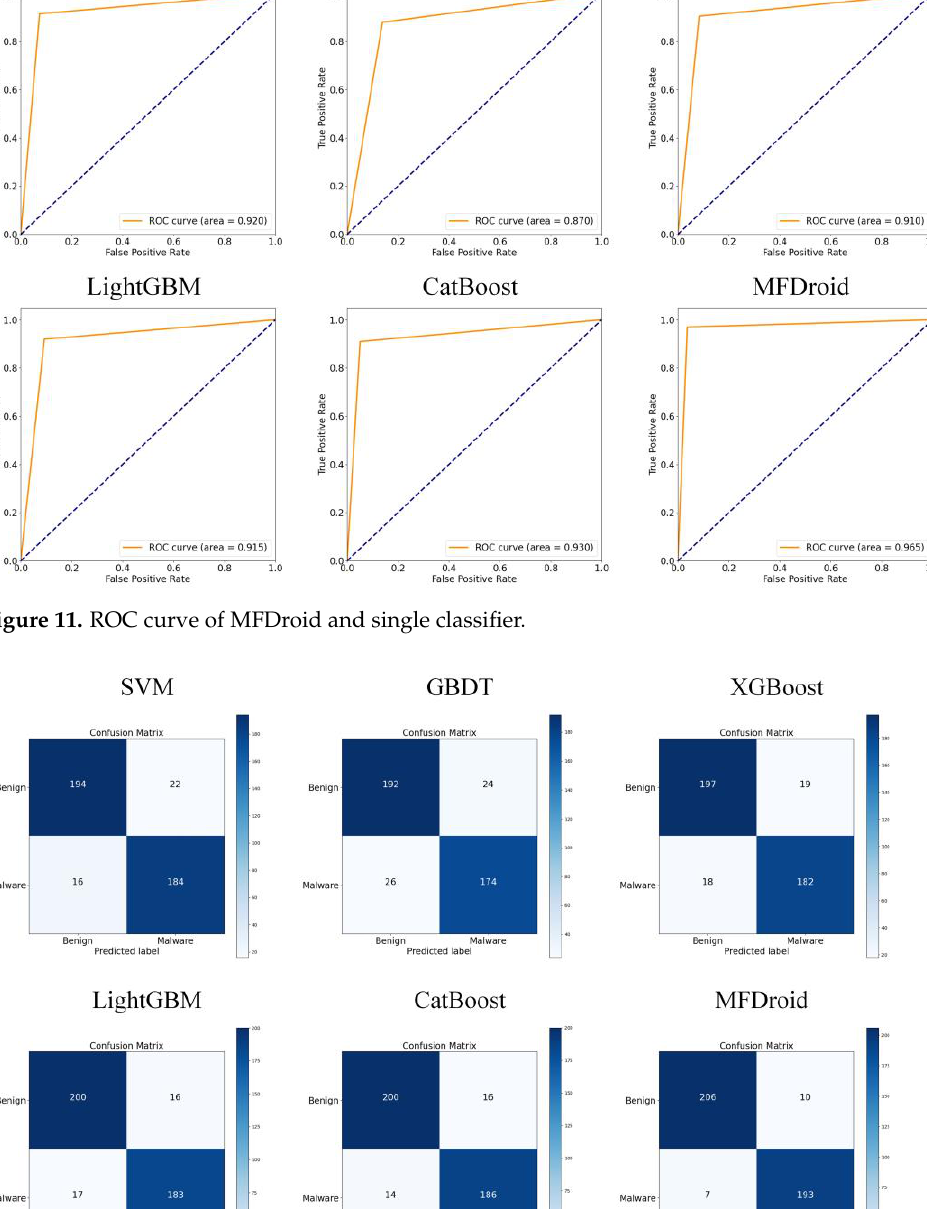
Figure 12. Confusion matrix of MFDroid and single classifier.